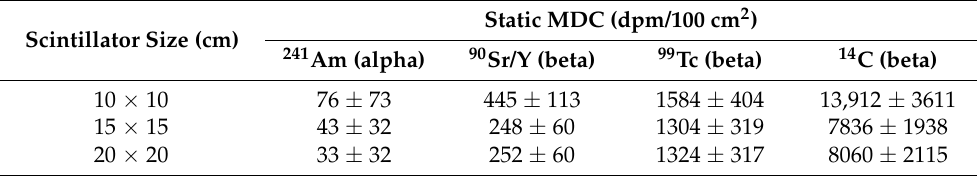
Figure 27. Description of the Phoswich detector system for simultaneous alpha/beta detection ( a ) and a schematic diagram of alpha and beta counting setup and PSD results ( b ) [60]. Table 4. Static MDCs for 1 min measurements depending on probe size [60].